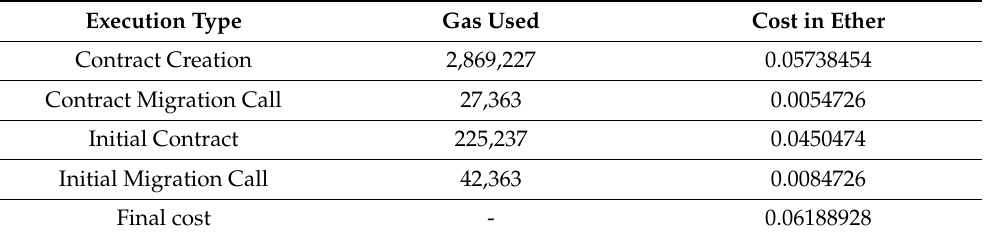
Table 3. Cost analysis for executing smart contracts (gas cost = 2 Gwei).